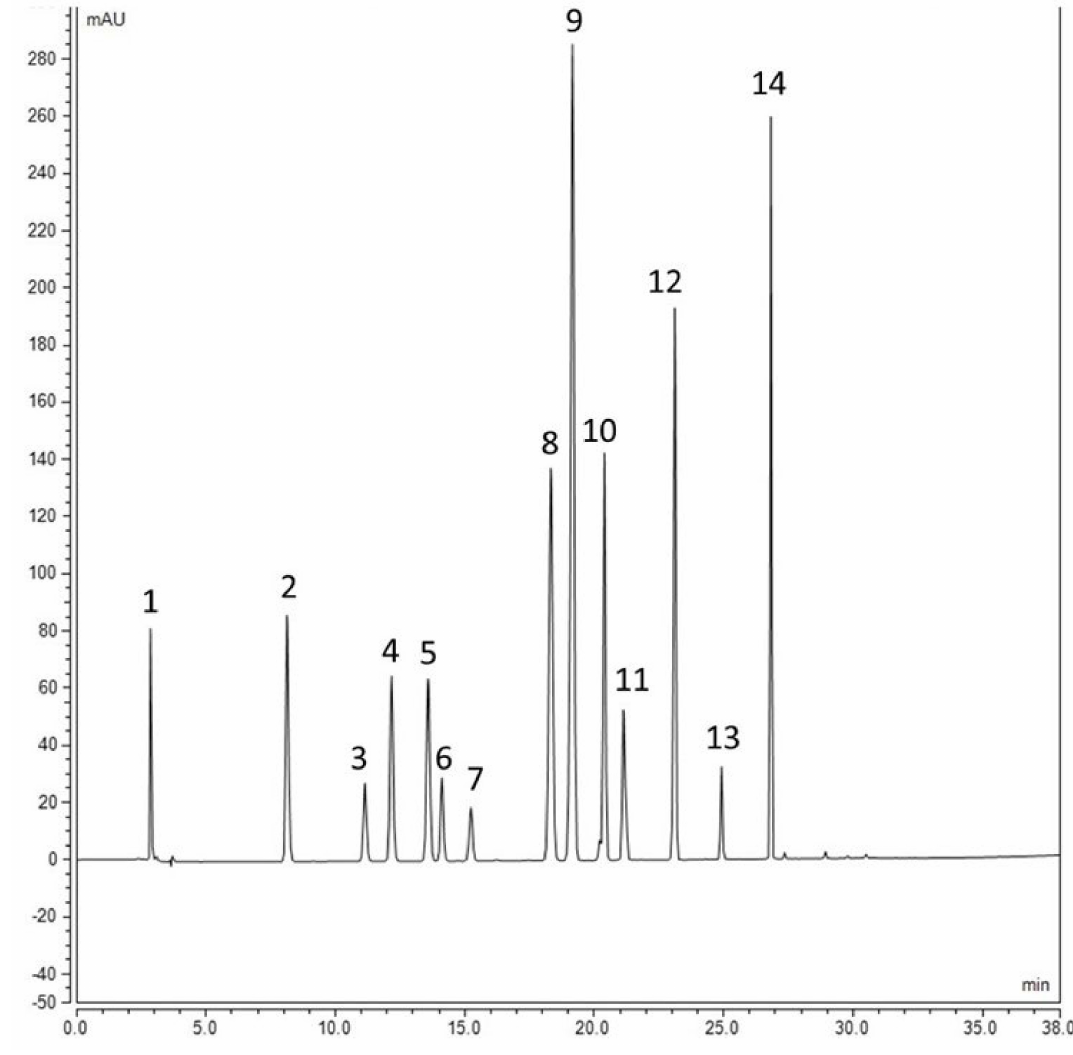
Figure 7. HPLC chromatogram of the standards tested. 1—Rt 2.857, Ascorbic acid; 2—Rt